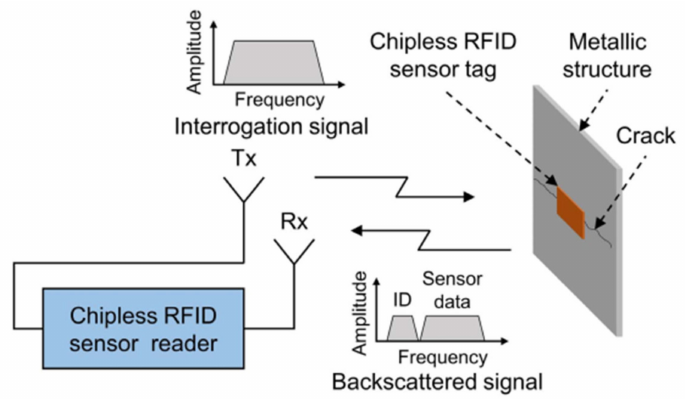
Figure 7. Basic principle of a chipless radio-frequency identification (RFID) sensor system for crack detection and characterization on a metallic structure